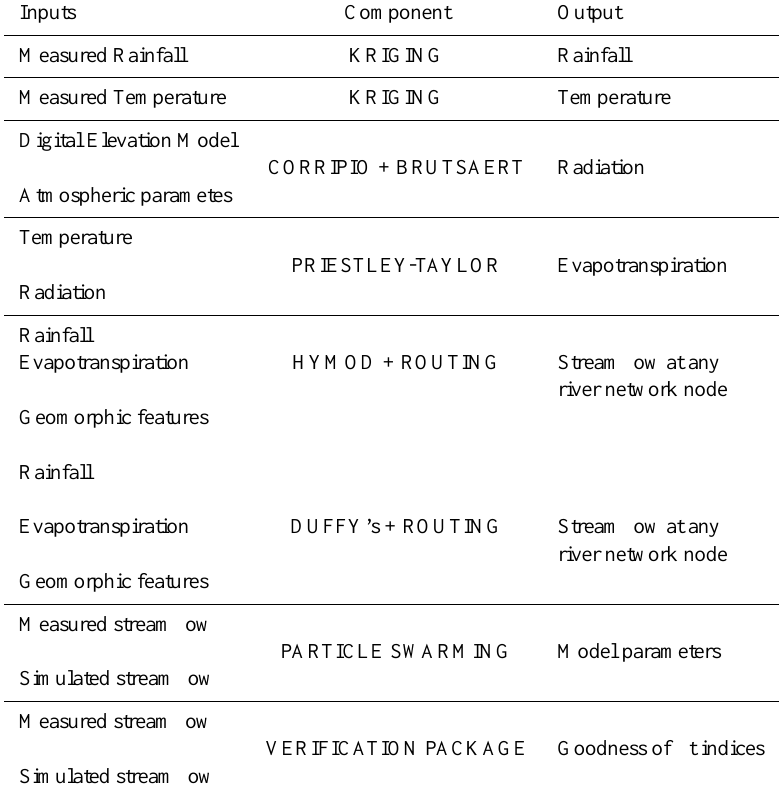
Table 1. OMS3 components used to constitute the JGrass-NewAge model. Where not specified, quantity in input or output must be intended as a spatial field for any instant of simulation time. “Measured” refers to a quantity that is measured at a meteorological station. Geomorphic features refer to the hilllslope and channel delineation, slope and aspect. The components, besides the specfied files received in input, include an appropriate set of parameter